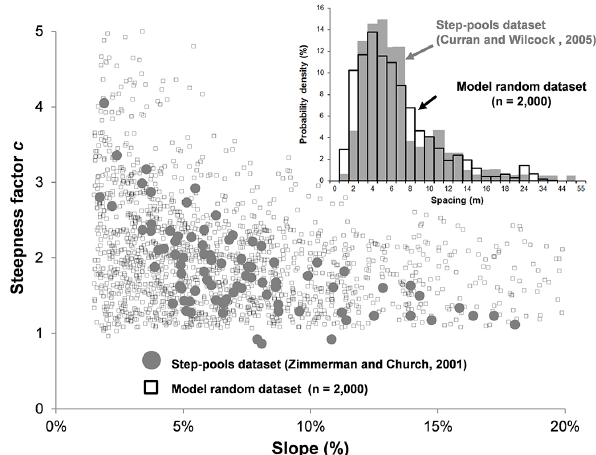
Fig. 10. Steepness factor c – slope relationship (main plot) and spac- ing frequency distribution (top-right corner) for the step-pool field data set – compiled by Zimmerman and Church (2001) and Curran and Wilcock (2005) – and the random data set generated by the conceptual